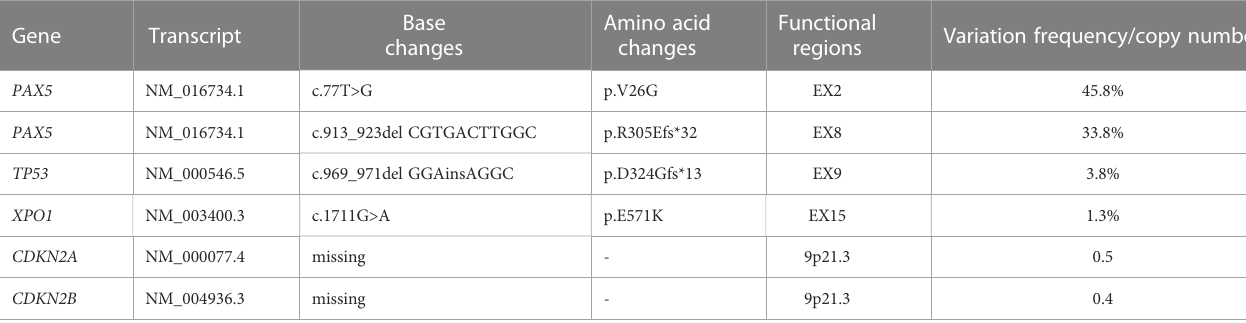
TABLE 1 Genome variation detection